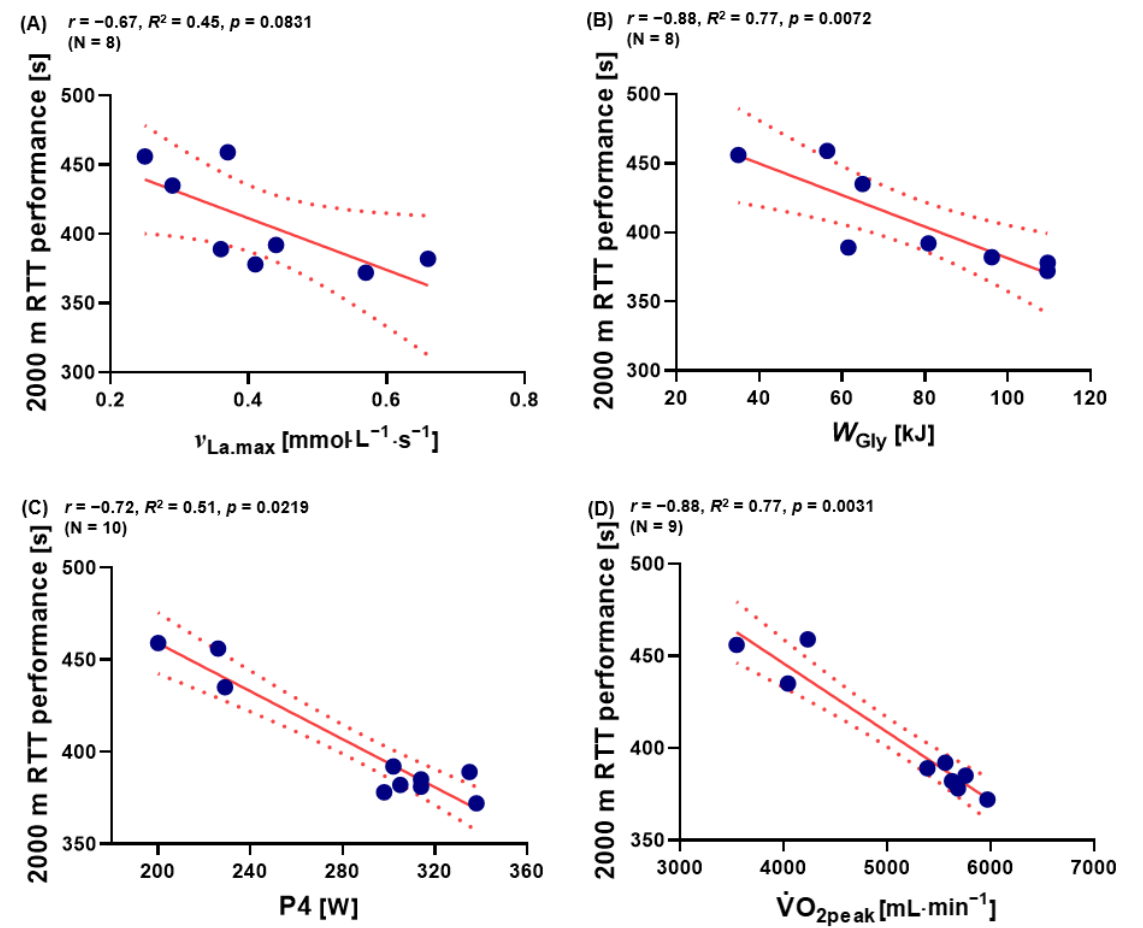
Figure 4. Relationship between ( A ) 2000 m RTT performance and ν La.max ( n = 8), between ( B ) 2000 m RTT performance and W Gly ( n = 8), between ( C ) P4 and 2000 m RTT performance ( N = 10), and between ( D ) 2000 m RTT performance and VO 2peak ( n = 9). VO 2peak : peak oxygen uptake during 2000 m RTT, P4: mechanical power output at 4 mmol · L − 1 . Dotted lines: 95% confidence interval, straight line: strength of the linear relationship between two variables.